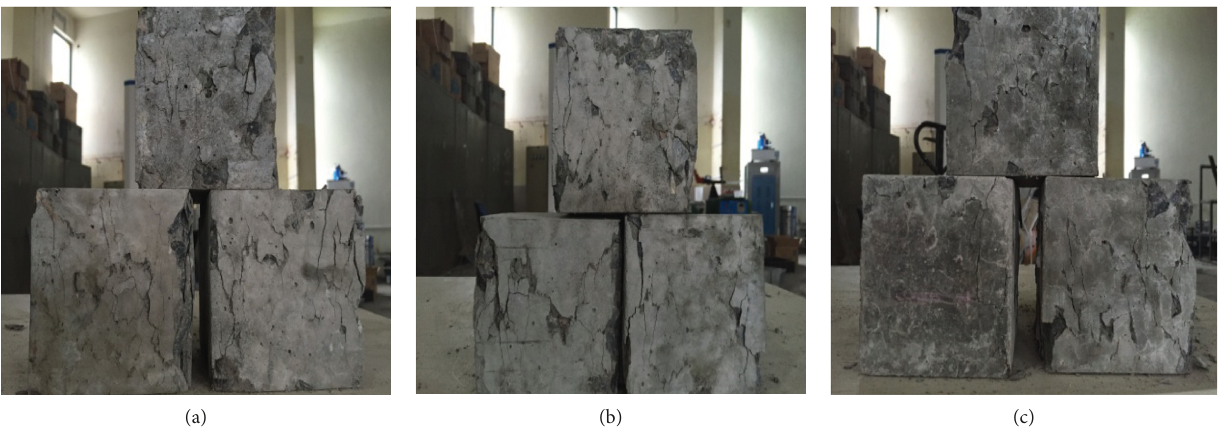
Figure 7: Failure pattern of a cubic specimen of directionally distributed SFRC under (perpendicular) compressive loading. (a) 0.4%; (b) 0.8%; (c)